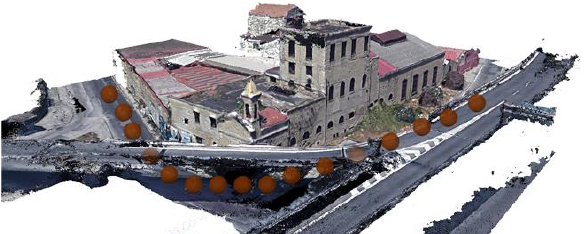
Figure 5 . Point cloud obtained with SfM algorithms applied to spherical panoramas that are correctly oriented.